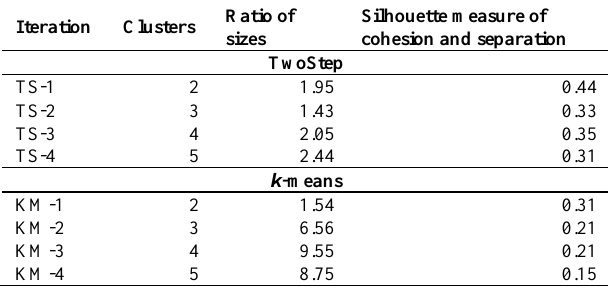
Table 4. Change in cluster size and quality over different cluster variations for TwoStep and k- means.